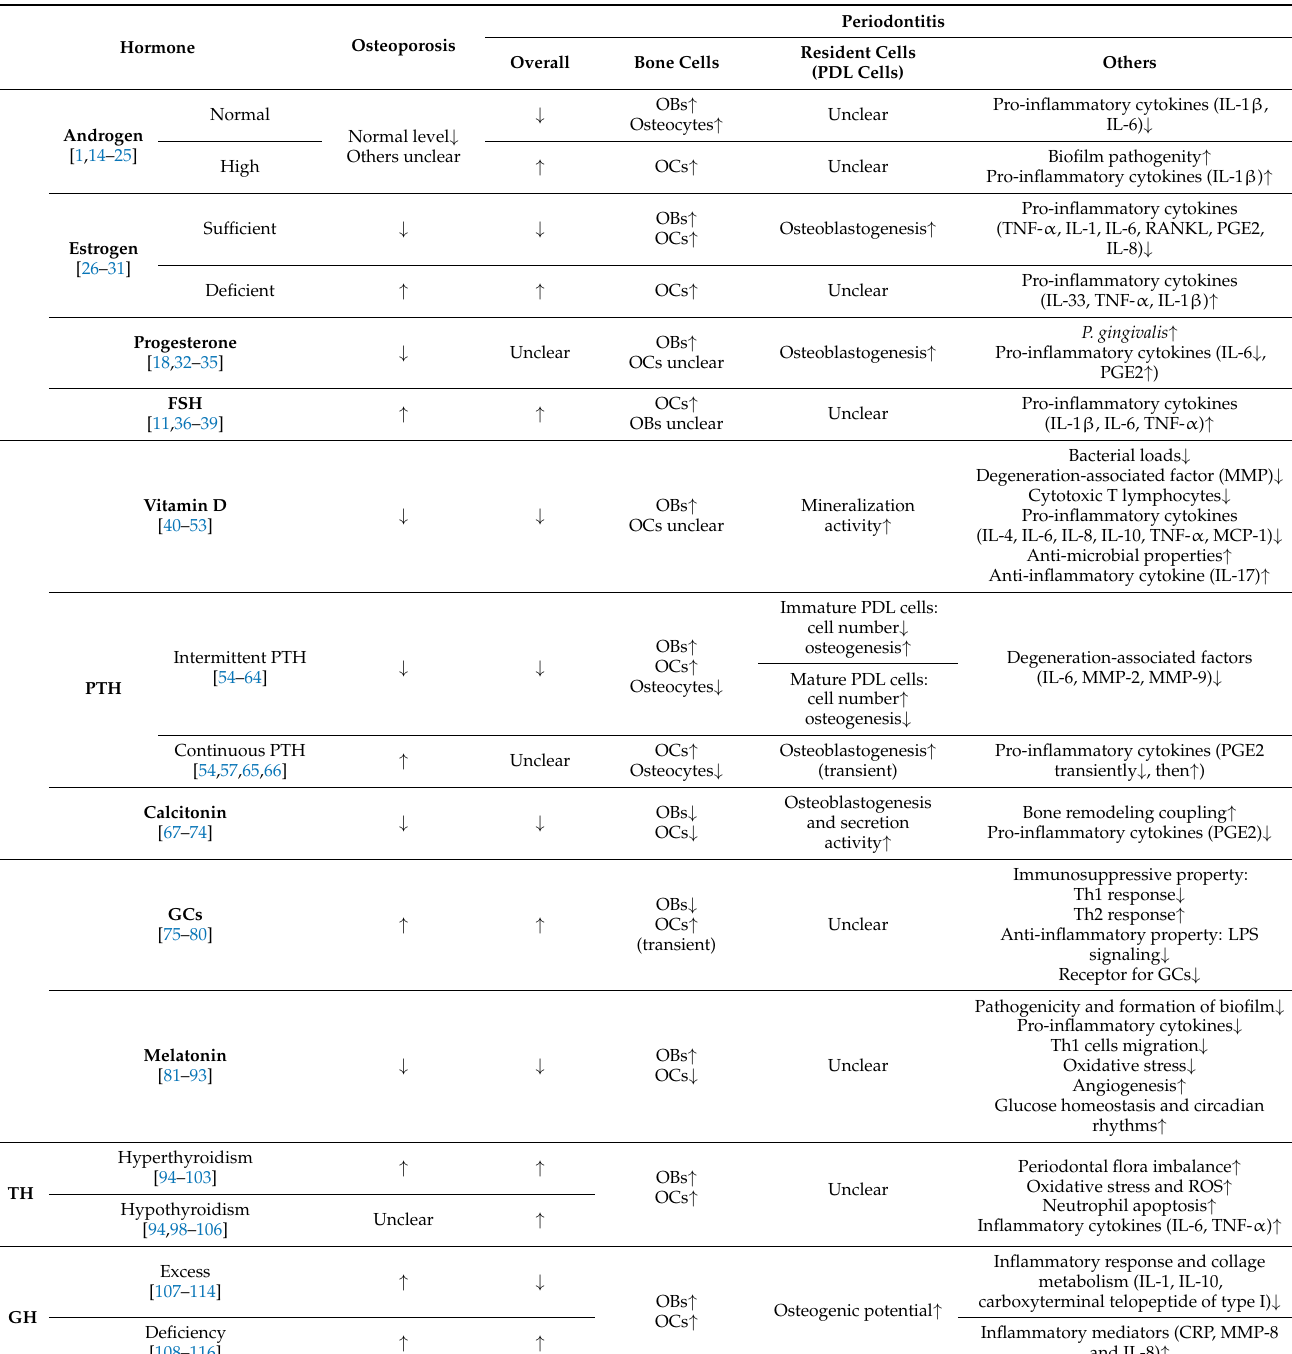
Table 1. Impact of hormones on osteoporosis and